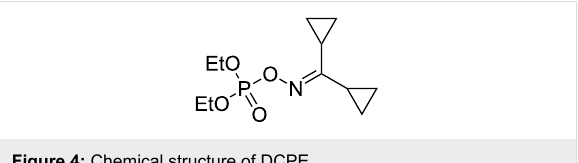
Figure 4: Chemical structure of